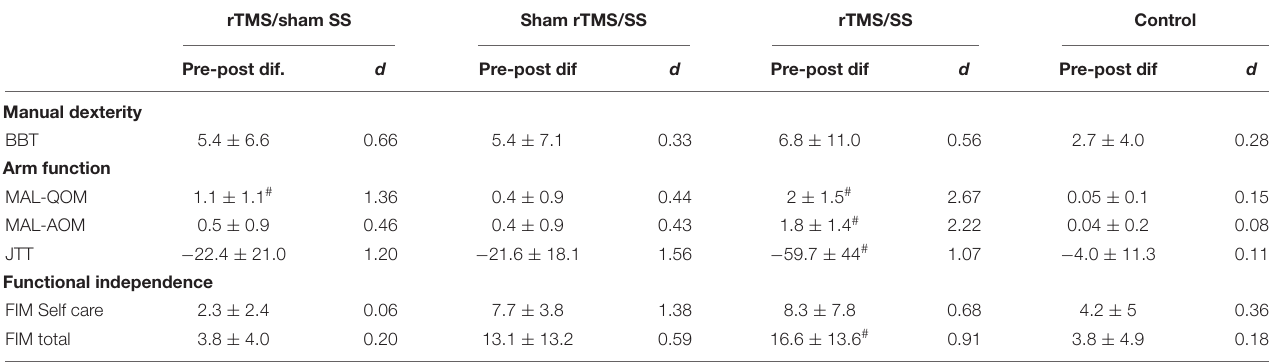
TABLE 3 | Secondary outcomes–activity/participation domains of the International Classification of Functioning, Disability, and Health (ICF). rTMS/sham SS Sham rTMS/SS rTMS/SS Control Pre-post dif. d Pre-post dif Pre-post dif Pre-post dif